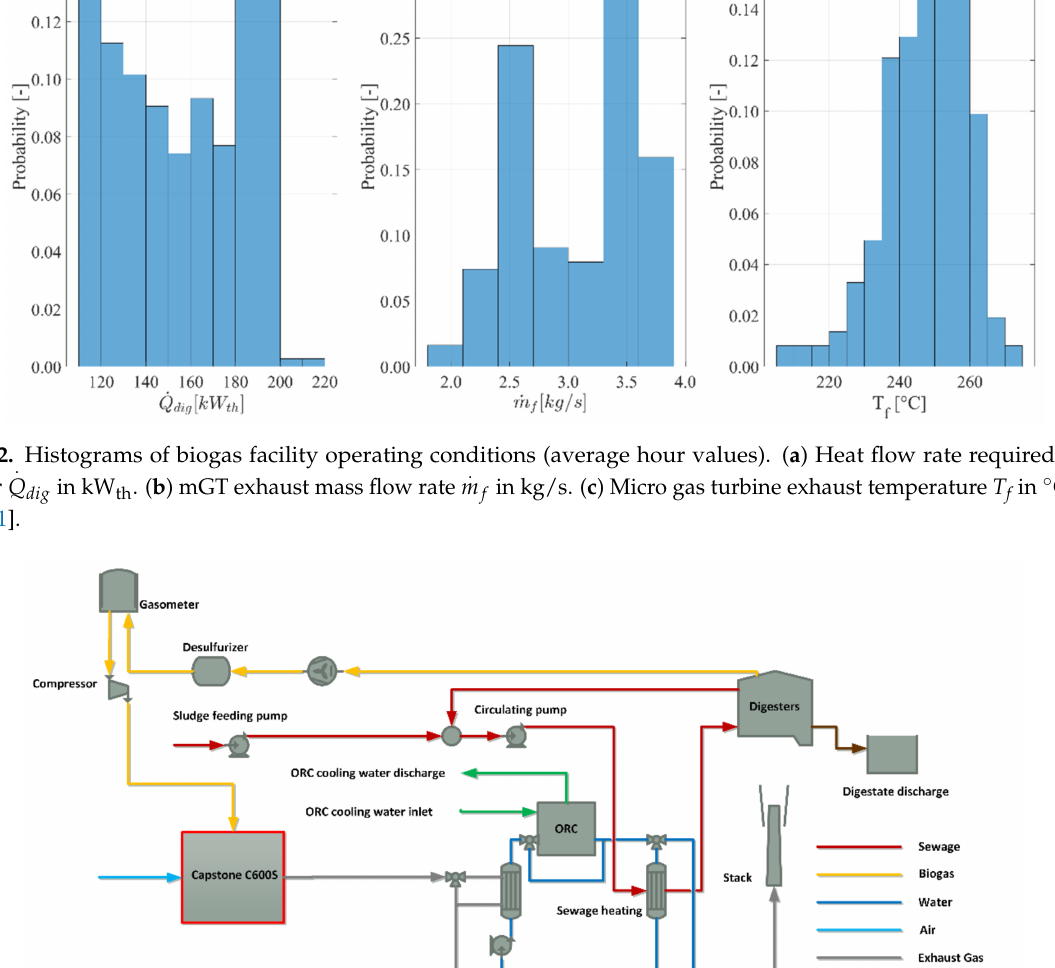
Figure 3. Anaerobic digestion biogas facility with the upgraded layout. The turbine exhaust gases power an organic rankine cycle (ORC) before heating the